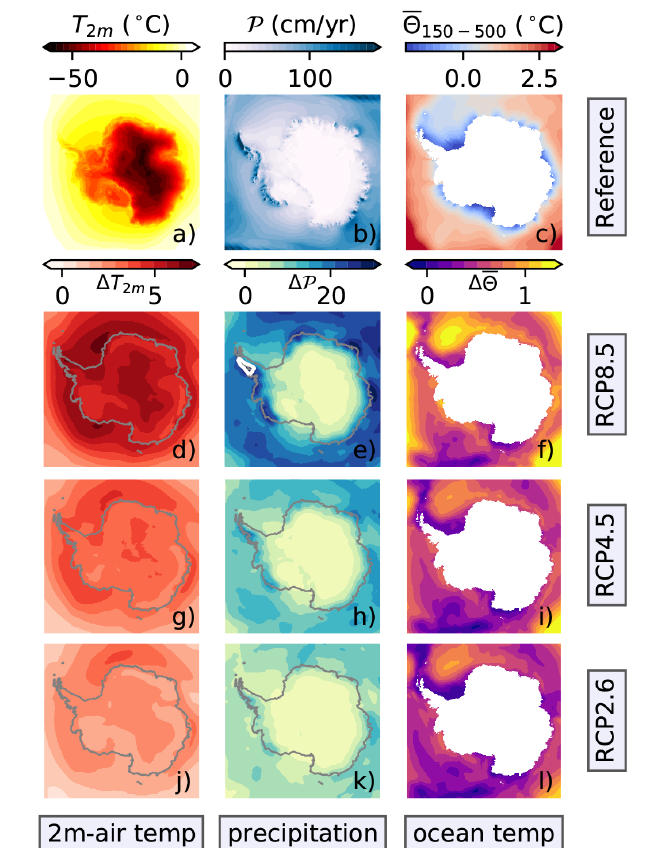
Figure 2. CMIP5 data set mean anomalies (d–l) relative to the at- mospheric (a, b) and oceanographic (c) reference forcing. The cor- responding maximum and minimum fields are depicted in Figs. E1 and E2, respectively. Panels (a–c) represent the reference fields to spin the ice sheet model up (Table 2). The 2m air temperature (a) and the total precipitation (b) are mean fields from the regional RACMO model, and the ocean temperatures (c) come from the World Ocean Atlas 2009; see Table 2 for more details. The color bar for each reference field is given above the respective plot. Below each reference field, the related anomalies, including their color bar, are compiled for the period from 2071 to 2100. Here, the second, third, and fourth rows show the anomalies for RCP8.5, RCP4.5, and RCP2.6, respectively. In these atmospheric anomaly plots, the dark- gray line follows the current coastline. All potential ocean tempera- tures (c, f, i, l) are a vertical mean of the depth interval from 150 to 500m. The white contour lines in the anomaly plots (e, h, k) high- light the 30cmyr − 1 precipitation threshold. All of these anoma- lies are the CMIP5 model means of the models listed in Table 1; CCSM4 is not part of RCP2.6. Antarctica’s contours are deduced from Fretwell et al. (2013).